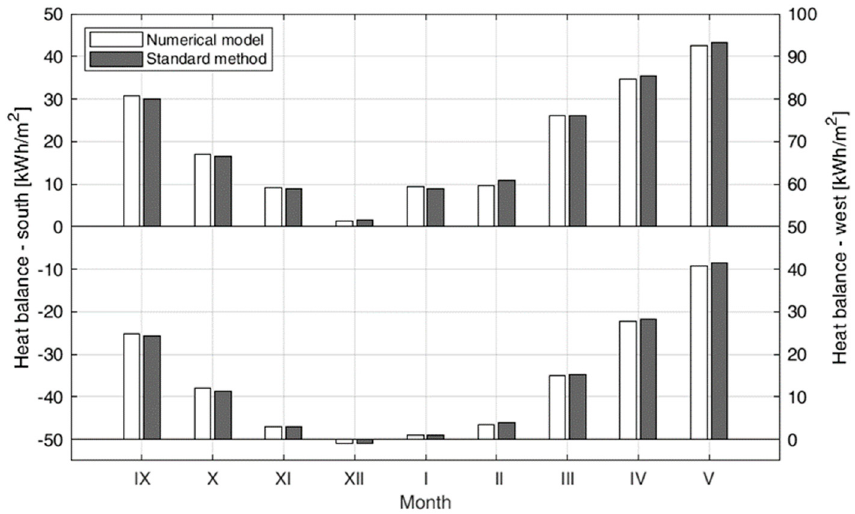
Figure 7. Comparison of results obtained using the standard method and a numerical model for Pozna ń (top—south orientation and bottom—west orientation).